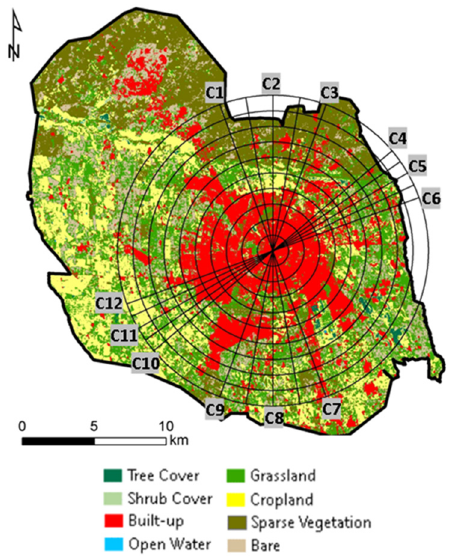
Figure 11. Land cover classification for the urban area of Marrakech (buffers shown every 1080 m).